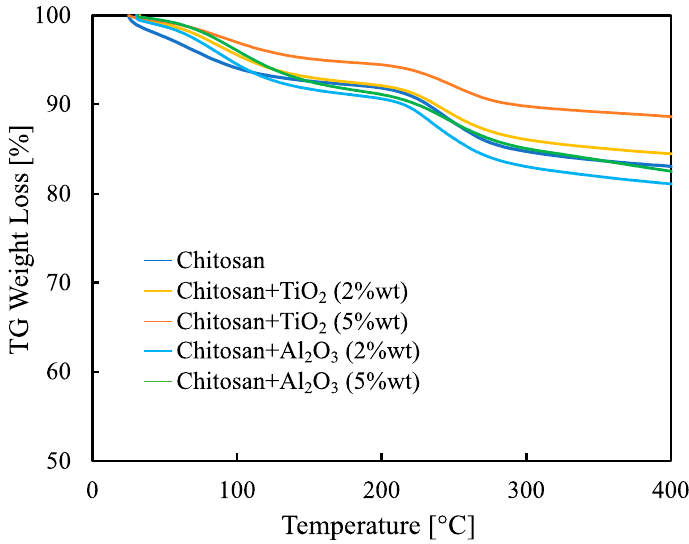
Figure 5. TG weight loss evaluated between 30 °C and 400 °C for all the synthesized membranes.